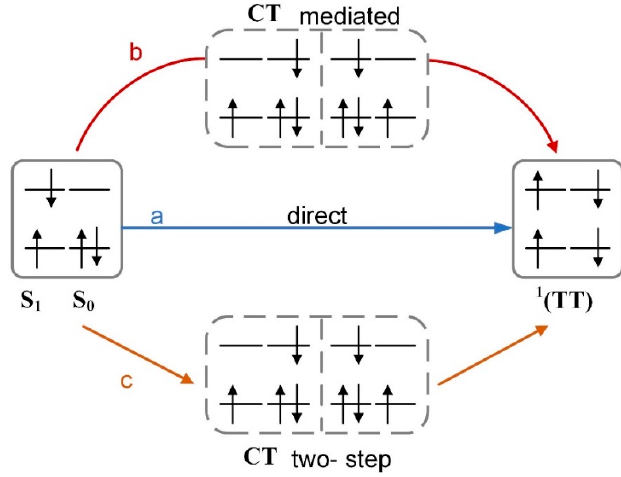
Figure 1. ( a ) Direct, ( b ) mediated, and ( c ) two-step mechanism of the SF process.